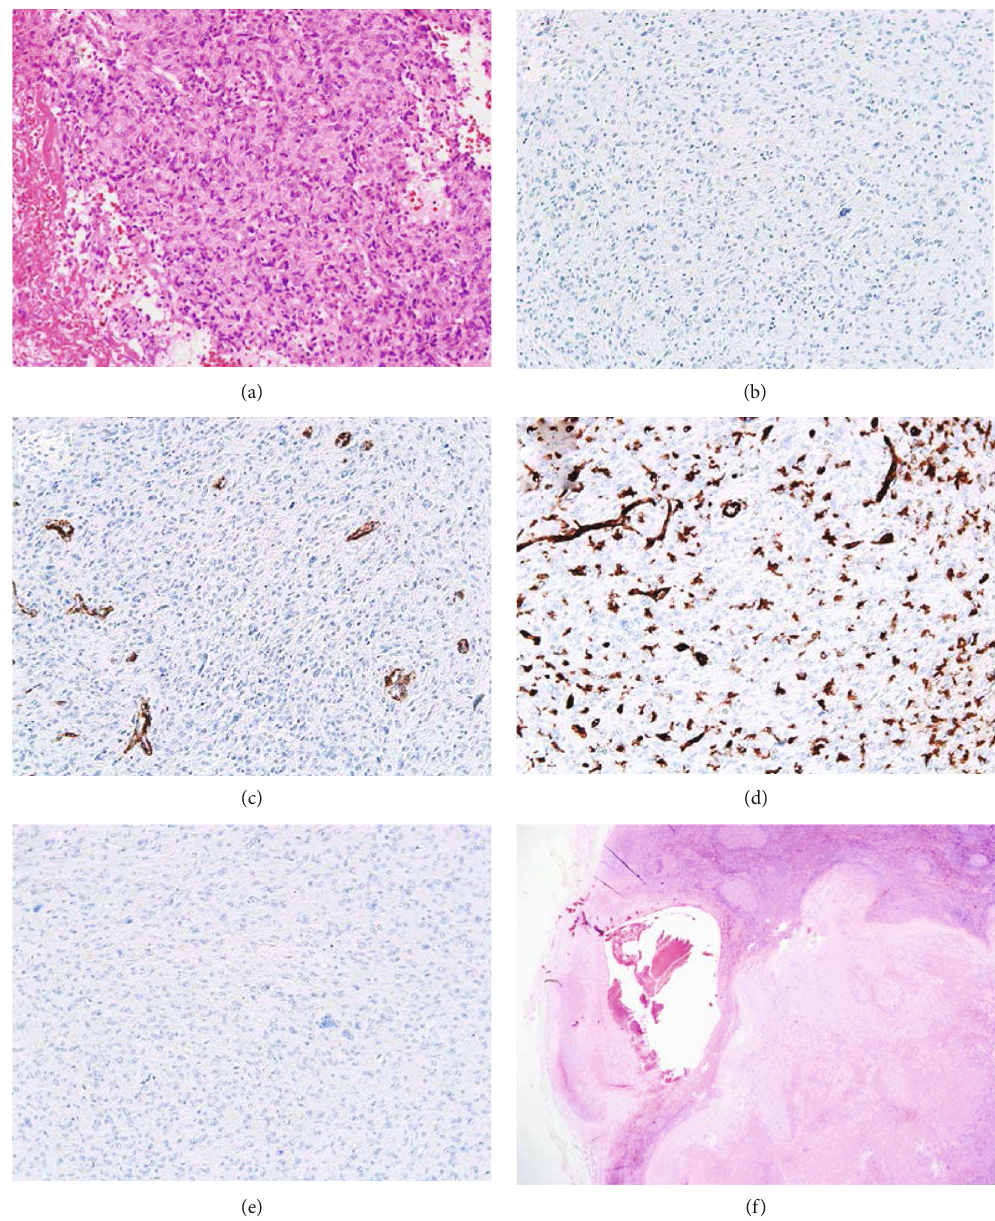
Figure 2: Photomicrographs of the angiomatoid fi brous histiocytoma. (a) Local recurrence featuring solid nodules of epithelioid to spindle cells arranged in a syncytial pattern with peripheral blood cells (hematoxylin and eosin (HE) stain, × 200). Tumor cells negative for (b) S-100 protein, (c) smooth muscle actin, (d) CD31, and (e) STAT6 (immunohistochemical stains, × 200). (f) Excisional biopsy revealing inguinal node metastasis of the tumor (HE, ×